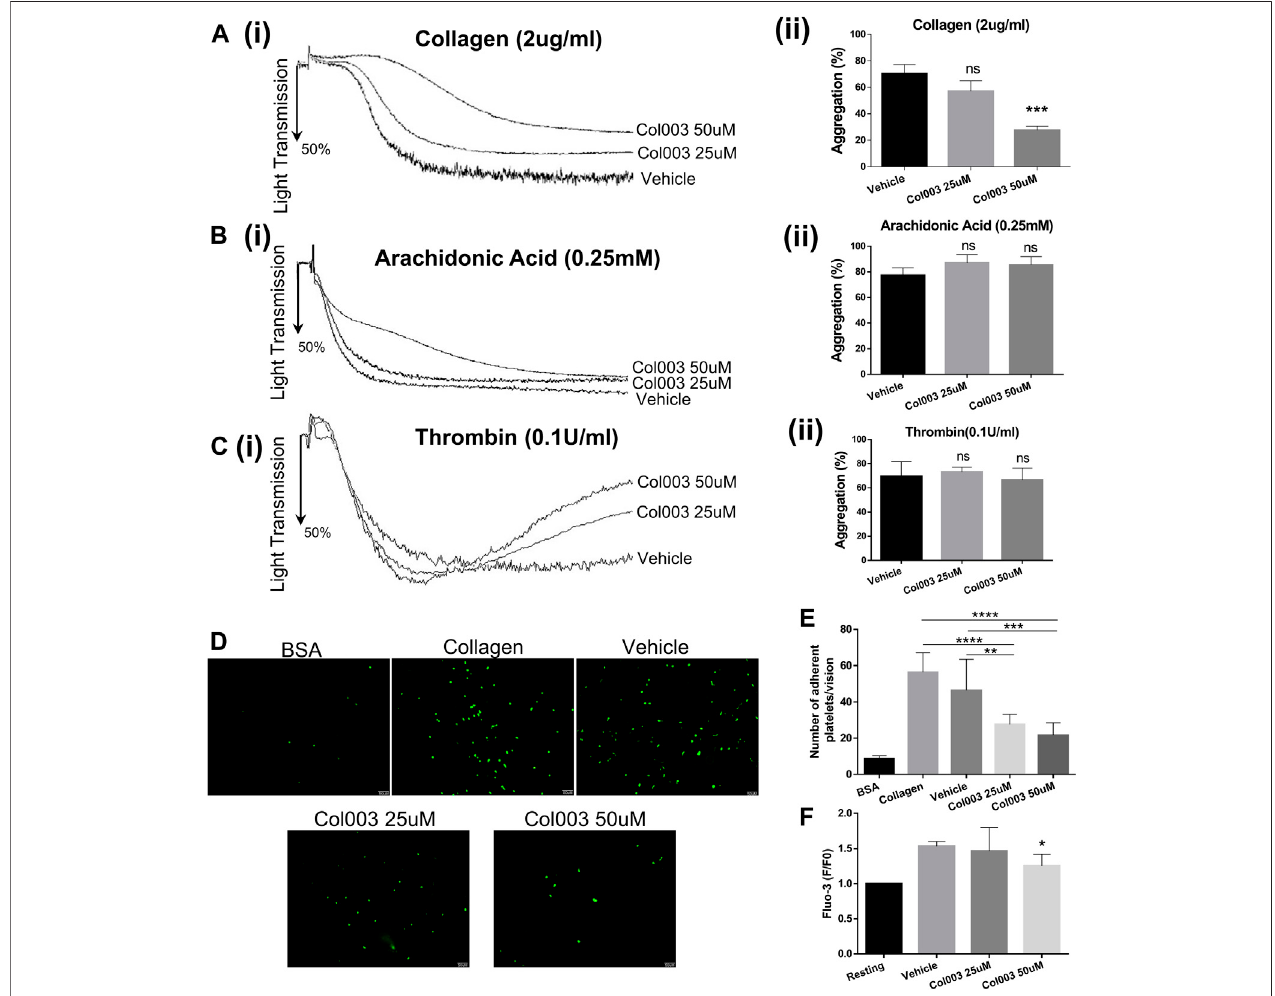
FIGURE 2 | Effects of Col003 on platelet aggregation induced by various agonists and platelet adhesion and Ca 2+ intra-platelet calcium fl ux induced by collagen. Washed rat platelets (3 × 10 8 /ml) were pre-incubated 5 minutes with the indicated concentrations of Col003 or vehicle followed by the addition of collagen (Ai) , arachidonic acid (Bi) , or thrombin (Ci) . The aggregation rates (%) were quanti fi ed (Aii, Bii, Cii; *** p < 0.001, vs vehicle). The aggregation rates (%) in collagen-induced group were 70.33 ± 3.93% (Vehicle), 57.00 ± 4.58% (Col003 25uM), 27.67 ± 1.76% (Col003 50uM), respectively. The aggregation rates (%) in arachidonic acid- induced group were 77.33 ± 3.28% (Vehicle), 87.00 ± 3.79% (Col003 25uM), 85.33 ± 3.84% (Col003 50uM), respectively. The aggregation rates (%) in thrombin- induced group were 69.67 ± 6.89% (Vehicle), 73.00 ± 2.31% (Col003 25uM), 66.33 ± 5.70% (Col003 50uM), respectively. (D) Representative images of platelet adhesiononcollagen-coatedroundcoverslips. (E) Thenumberofadherentplateletspervisionwasquanti fi ed.Theadherencenumberofplateletsinthe fi vegroupswere 8.68 ± 0.58 platelets/vision (BSA), 56.44 ± 3.55 platelets/vision (Collagen), 46.44 ± 5.69 platelets/vision (Vehicle), 27.56 ± 1.88 platelets/vision (Col003 25uM), 21.67 ± 2.30 platelets/vision (Col003 50uM), respectively. ** p < 0.01, *** p < 0.001, and **** p < 0.0001. (F) The intracellular Ca 2+ concentration was measured by labeled Fluo-3 AM, and theFluo-3 fl uorescence ofplatelets waspresentednormalizedto the fl uorescence of resting platelets. The [Ca2+]i levels in thethree groups were 1.53- ± 0.04- foldofresting(Vehicle),1.47- ± 0.17-fold ofresting(Col00325uM),1.26- ± 0.08-foldofresting(Col00350uM),respectively.* p < 0.05(vsvehicle).Statisticalmethodsfor the above experiments using unpaired two-tailed Student ’ s t -test.